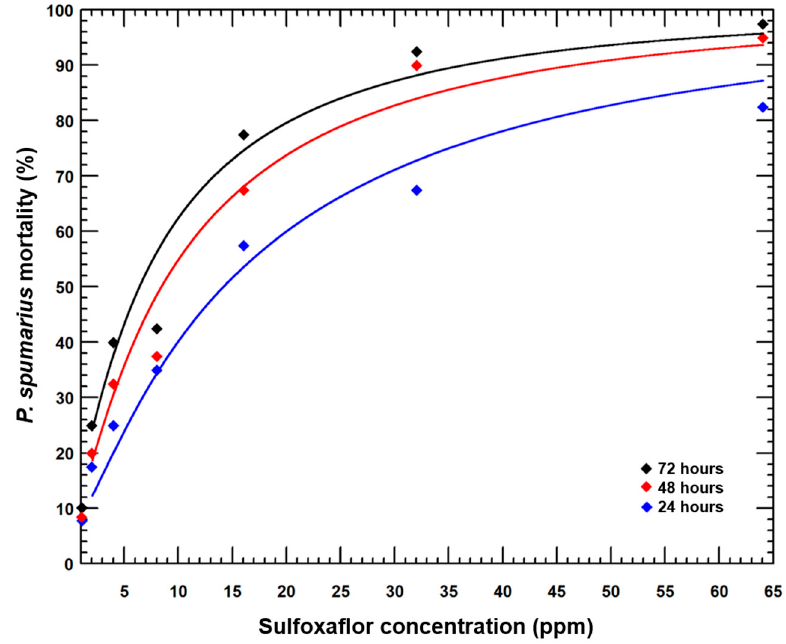
Figure 1. Probit regressions of mortality (%) of P. spumarius nymphs after 24, 48 and 72-h exposure in the lab to S. oleraceus plants treated with sulfoxaflor. 13